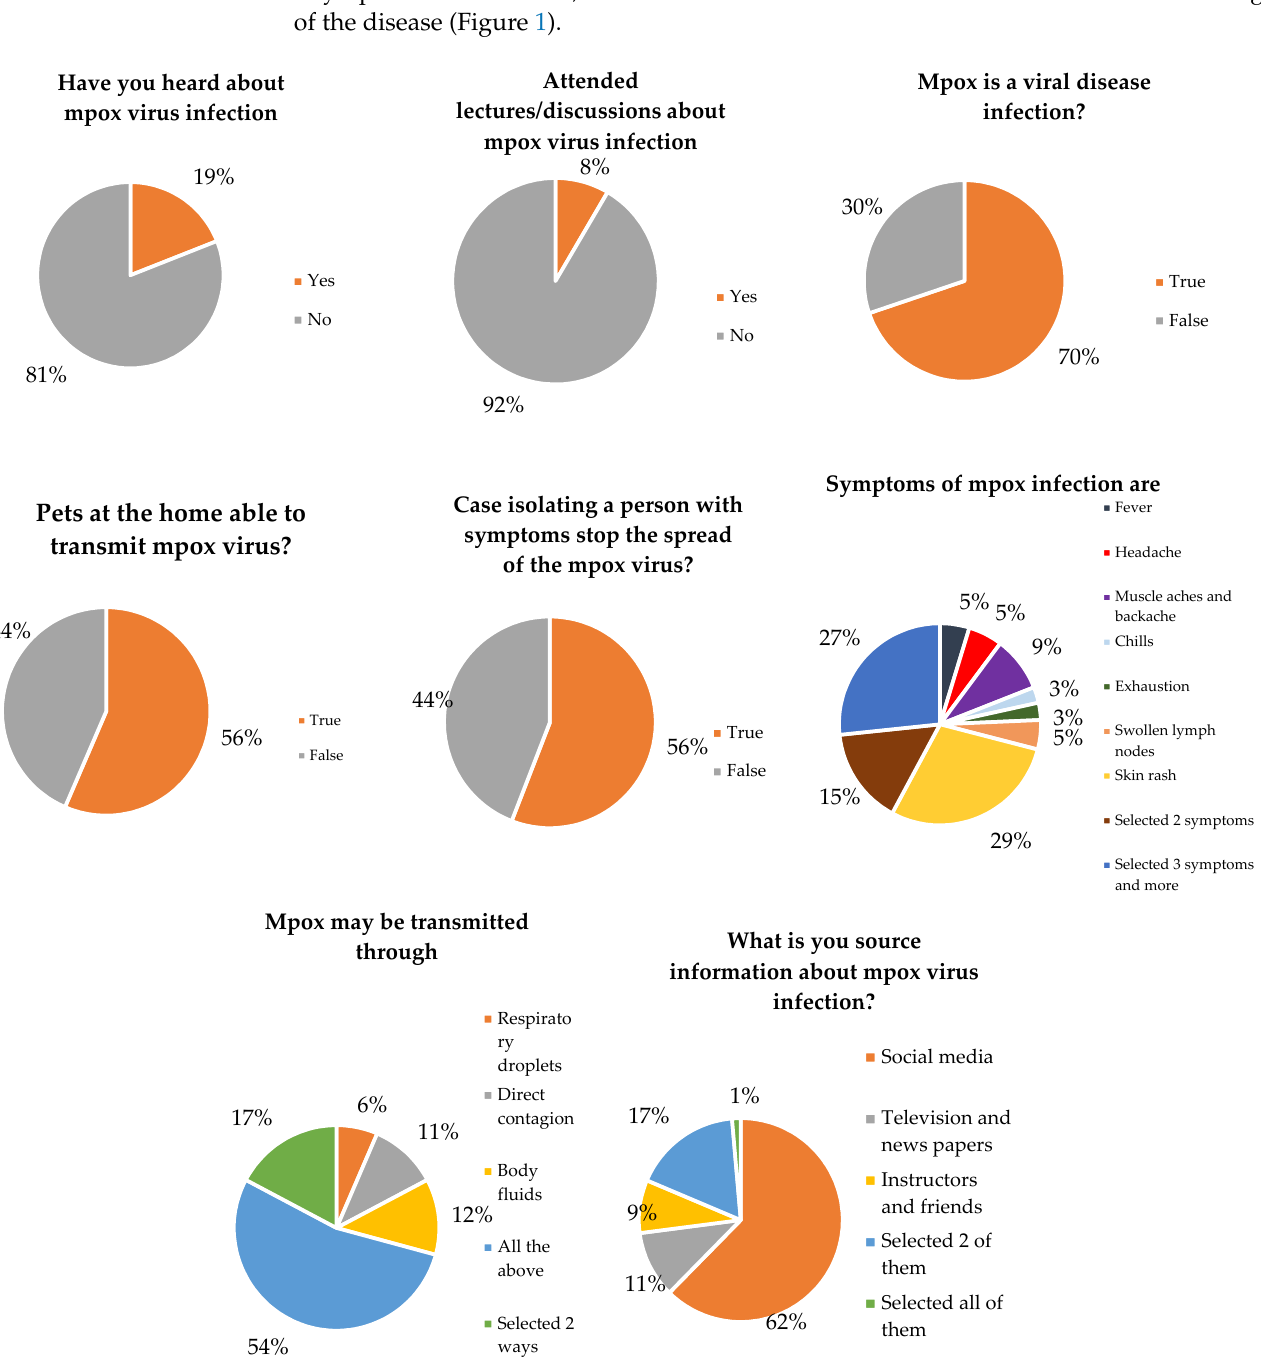
Figure 2. Attitude of participants about mpox viral infection ( n = 510). 3.4. Response Distribution of Worry toward the Mpox Outbreak The worry level of participants about the current mpox outbreak is presented in (Fig- ure 3). In the preceding two weeks, over half of the participants had been preoccupied by the mpox outbreak, ranging from sometimes to always. The fear of contracting the MPXV